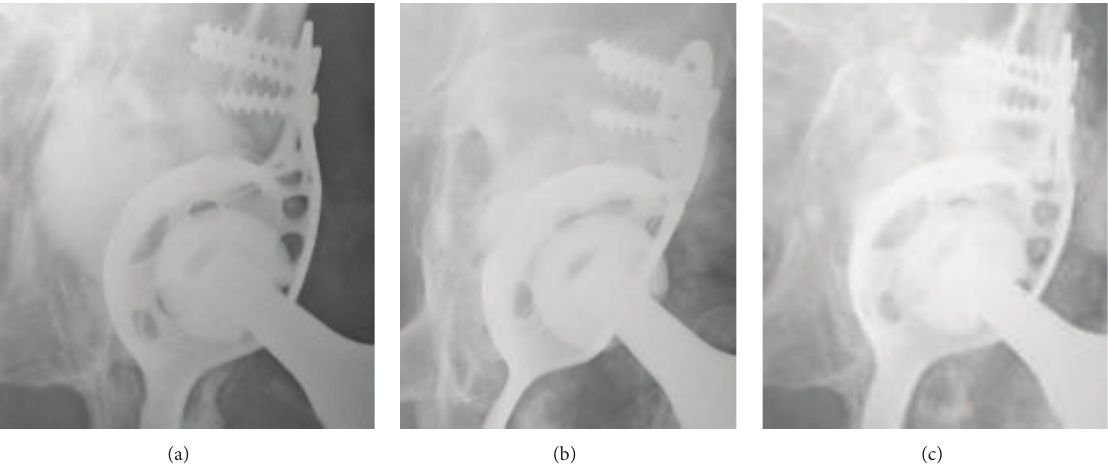
Figure 8: Enlargement of the a.p. X-rays of the left hip: at (a) two days, (b) one year, and (c) two years and eight months postoperatively: continuing remodelling of CERAMENT | BONE VOID FILLER into